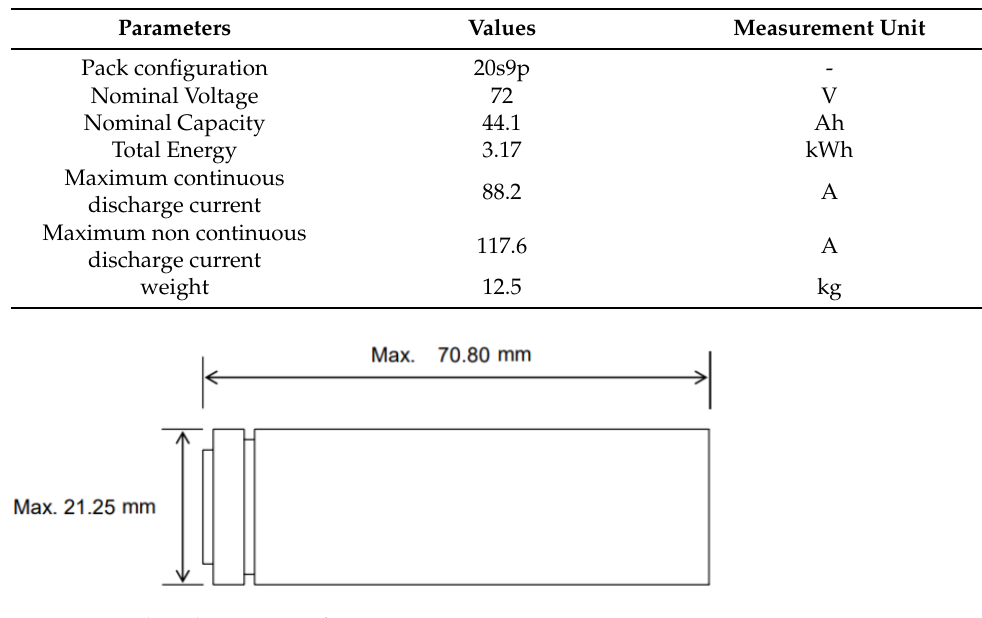
Figure 1. Outline dimensions of